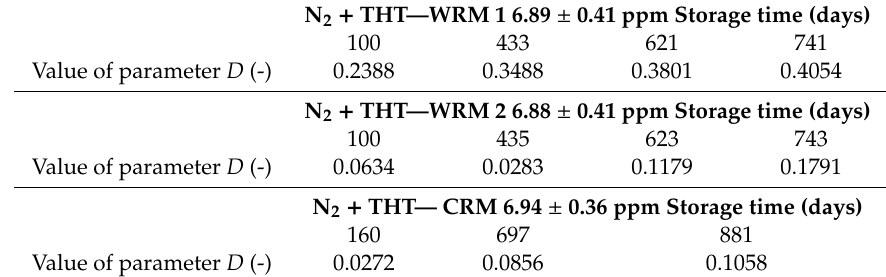
Table 5. List of the established values of the control parameter ( D ) for assessing the stability of THT mixtures in